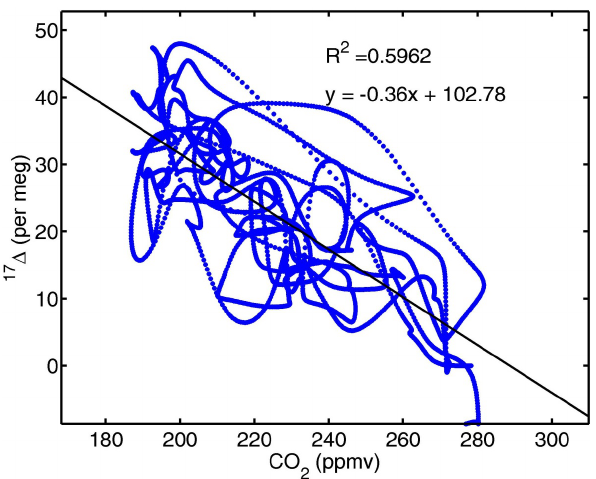
Fig. A1 17 1 vs. CO 2 from Fig. 1. See main text for details on the Figure A1: 17  versus CO 2 from figure 1. See main text for details on the 17  data. Compiled 2 17 1 data. Compiled CO 2 data are from Vostok, Taylor Dome and CO 2 data are from Vostok, Taylor Dome and EPICA Dome C (see main text for details and 3 EPICA Dome C (see main text for details and references). CO 2 references). CO 2 and 17 ∆ data are interpolated to 100 a intervals. 4 and 17 1 data are interpolated to 100yr intervals.